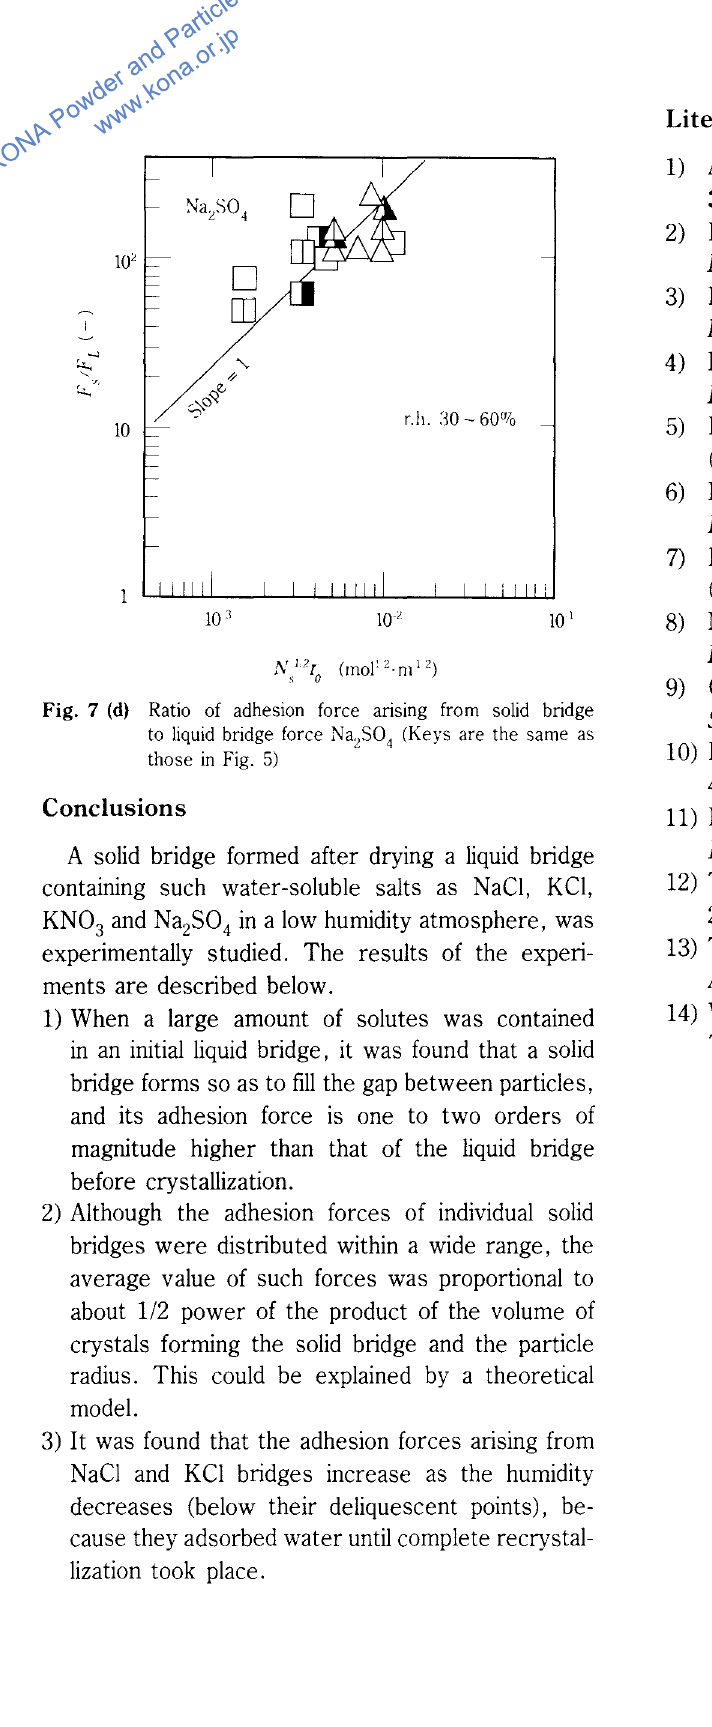
Table I", p.67, McGraw-Hill, New York